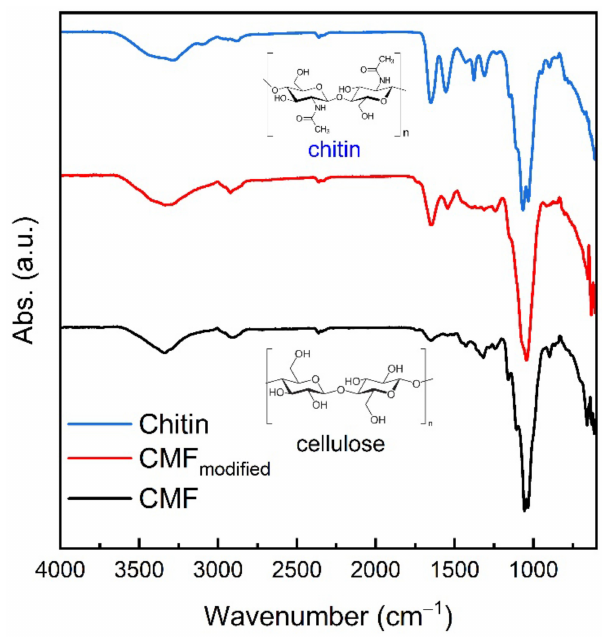
Figure 4. FTIR-spectra of pristine CMF, CMF modified , and crustacean